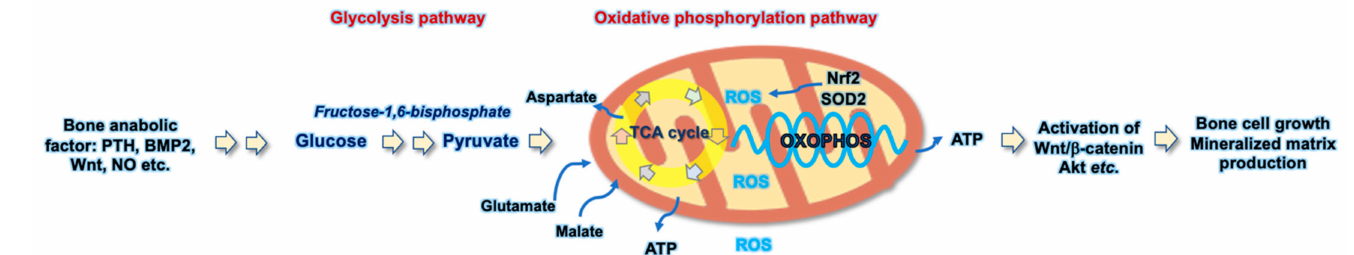
Figure 1. Schematic diagram showing the glycolysis and oxidative phosphorylation pathways involved in the bone-forming cell